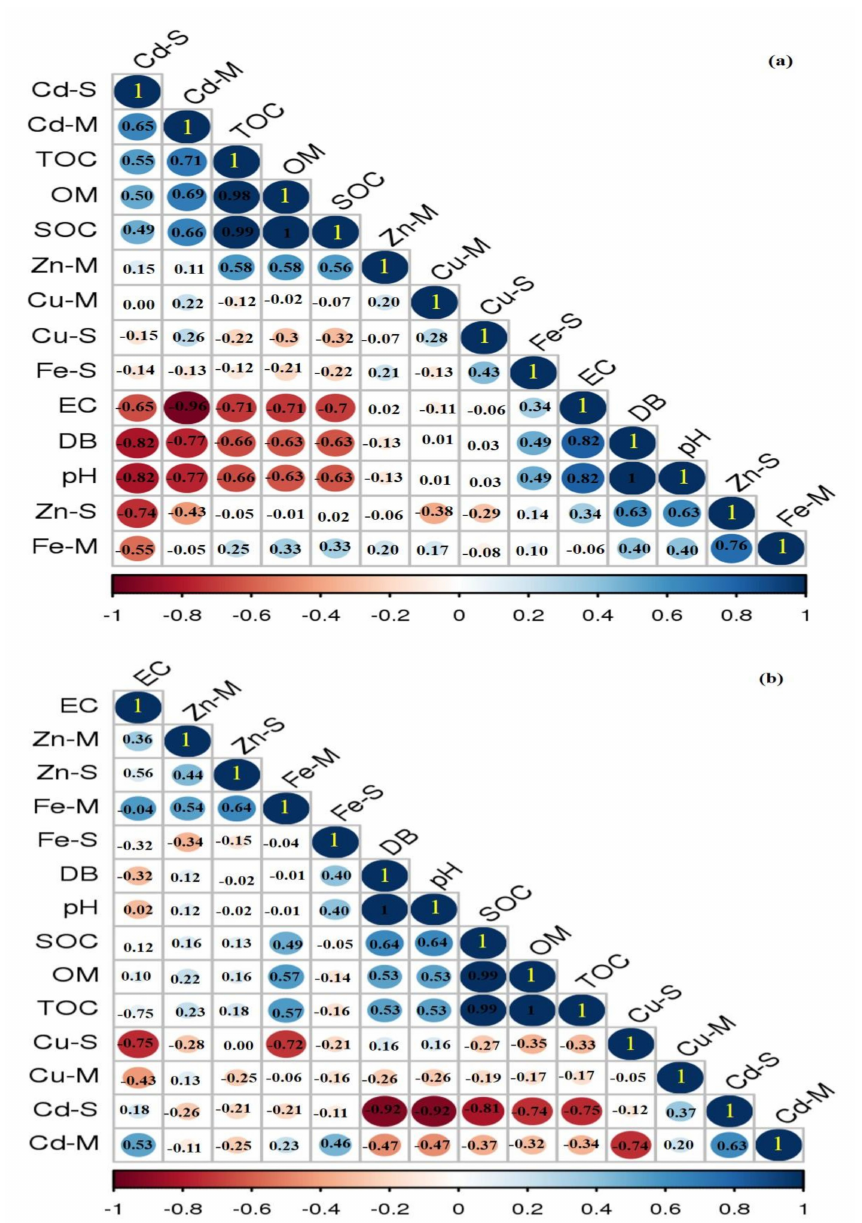
Figure 9. Correlation matrix between studied parameters in K-HP ( a ) and K-LP soils ( b